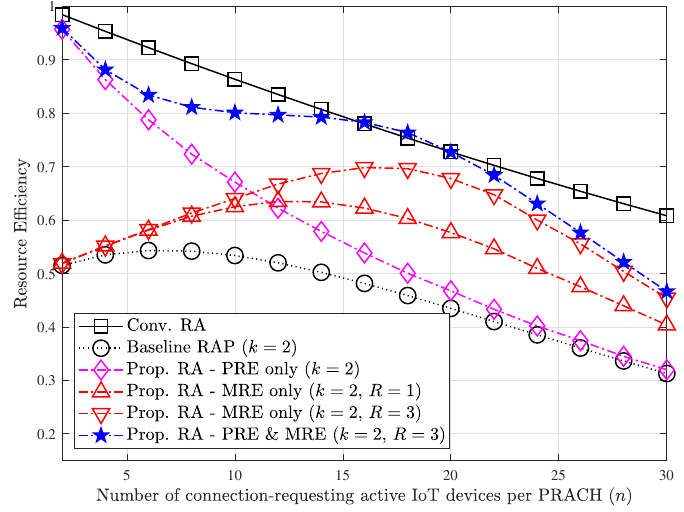
Figure 5. Effect of each of mechanisms on the resource